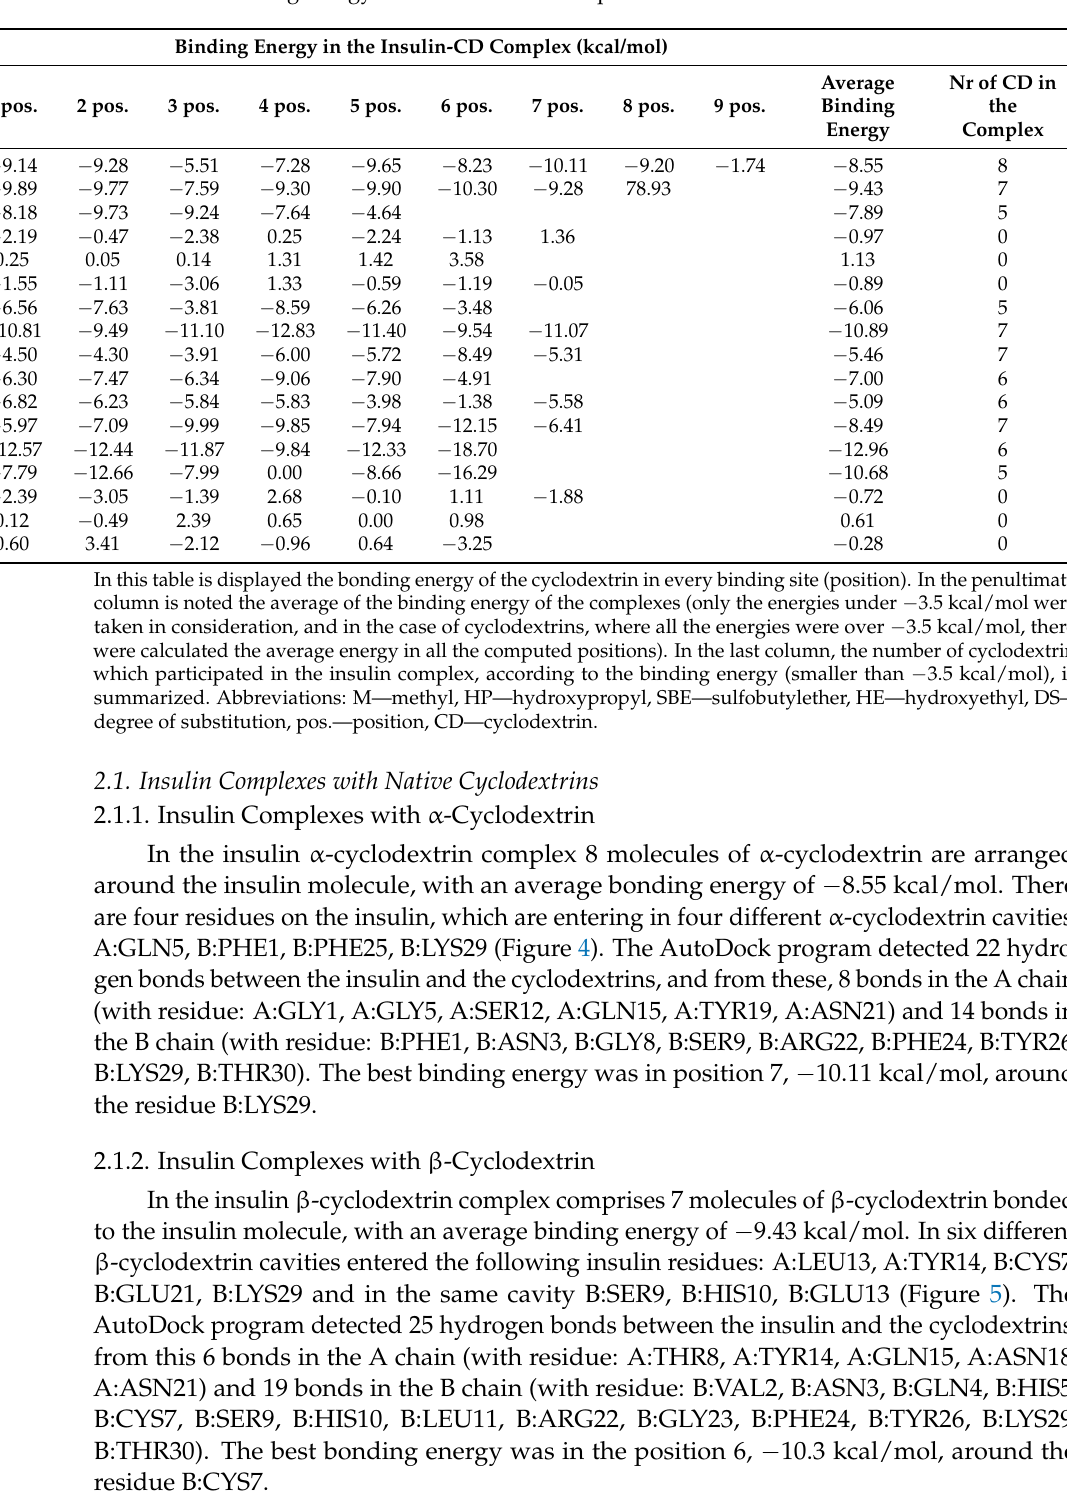
Table 1. The binding energy in the insulin-CD